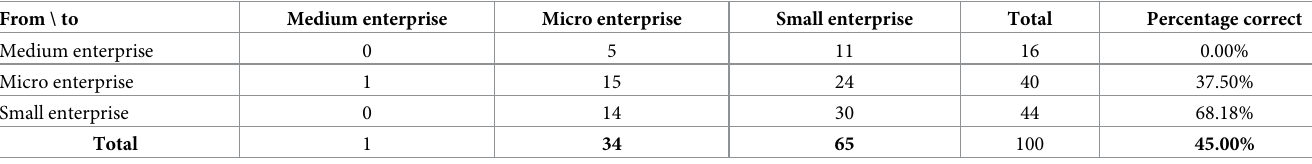
Table 7. Confusion matrix of different group of institutional trust. From \